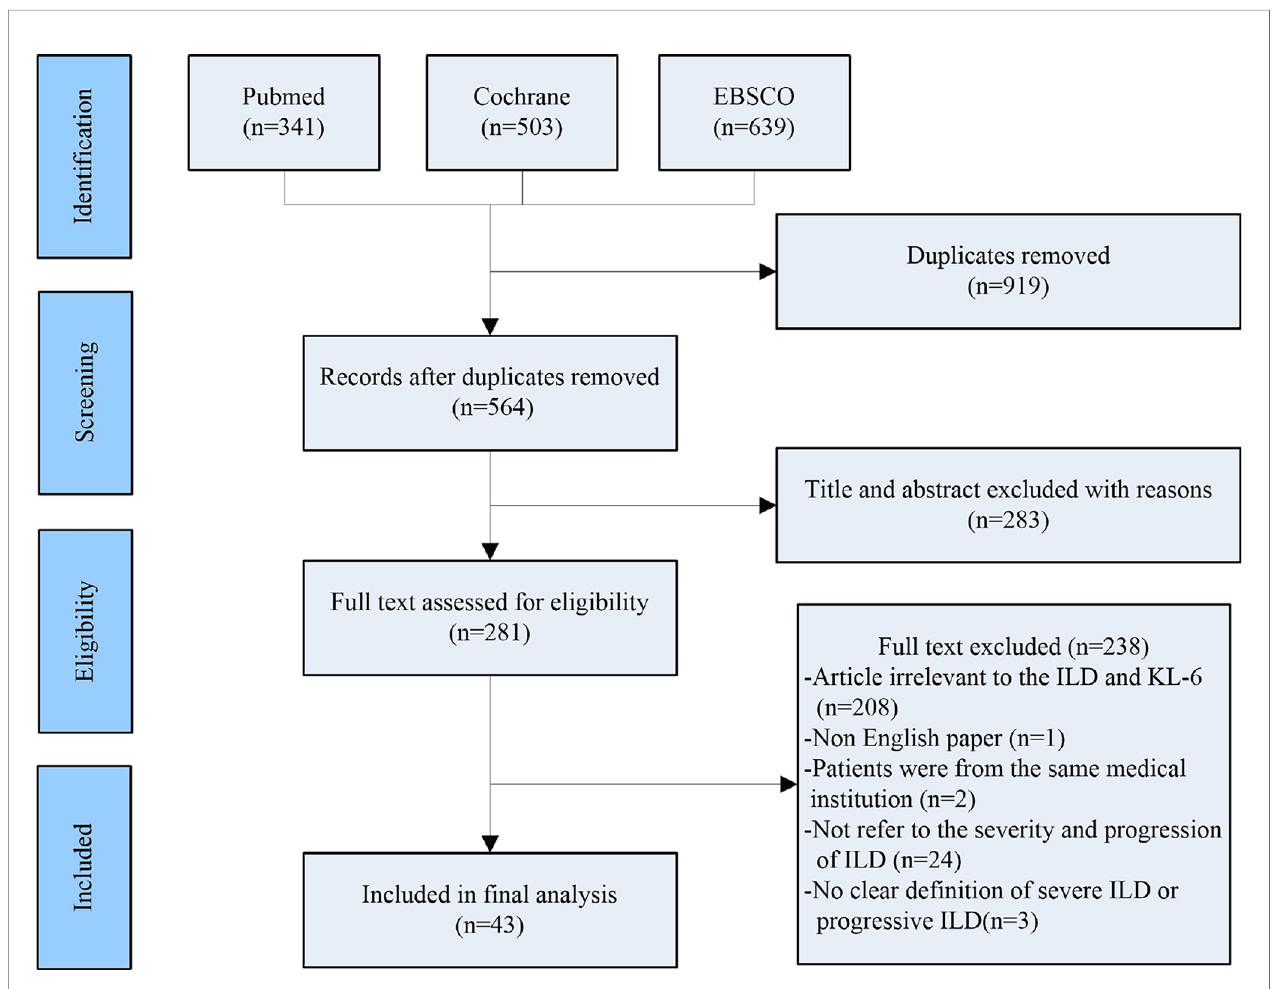
FIGURE 1 | The PRISMA diagram of the study